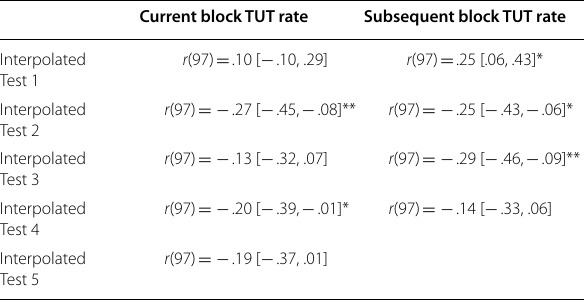
Table A1 Correlations [with 95% CIs] between interpolated-test performance and TUTs, by current block and subsequent